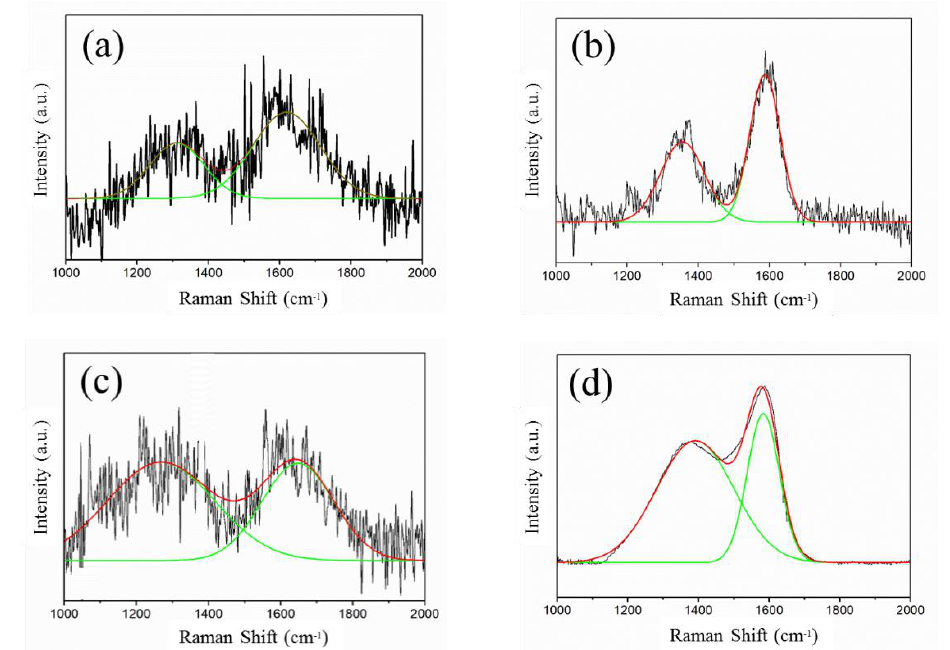
Figure 11. Typical Raman spectrum of DLC films deposited on titanium at ( a ) CH 4 /H 2 = 1:1, 6 h; ( b ) CH 4 /H 2 = 1:1, 12 h; ( c ) CH 4 /H 2 = 1:0, 6 h; ( d ) CH 4 /H 2 = 1:0, 12 h. Table 4. Metal ion concentration for the bare and DLC film-coated titanium after 168 h